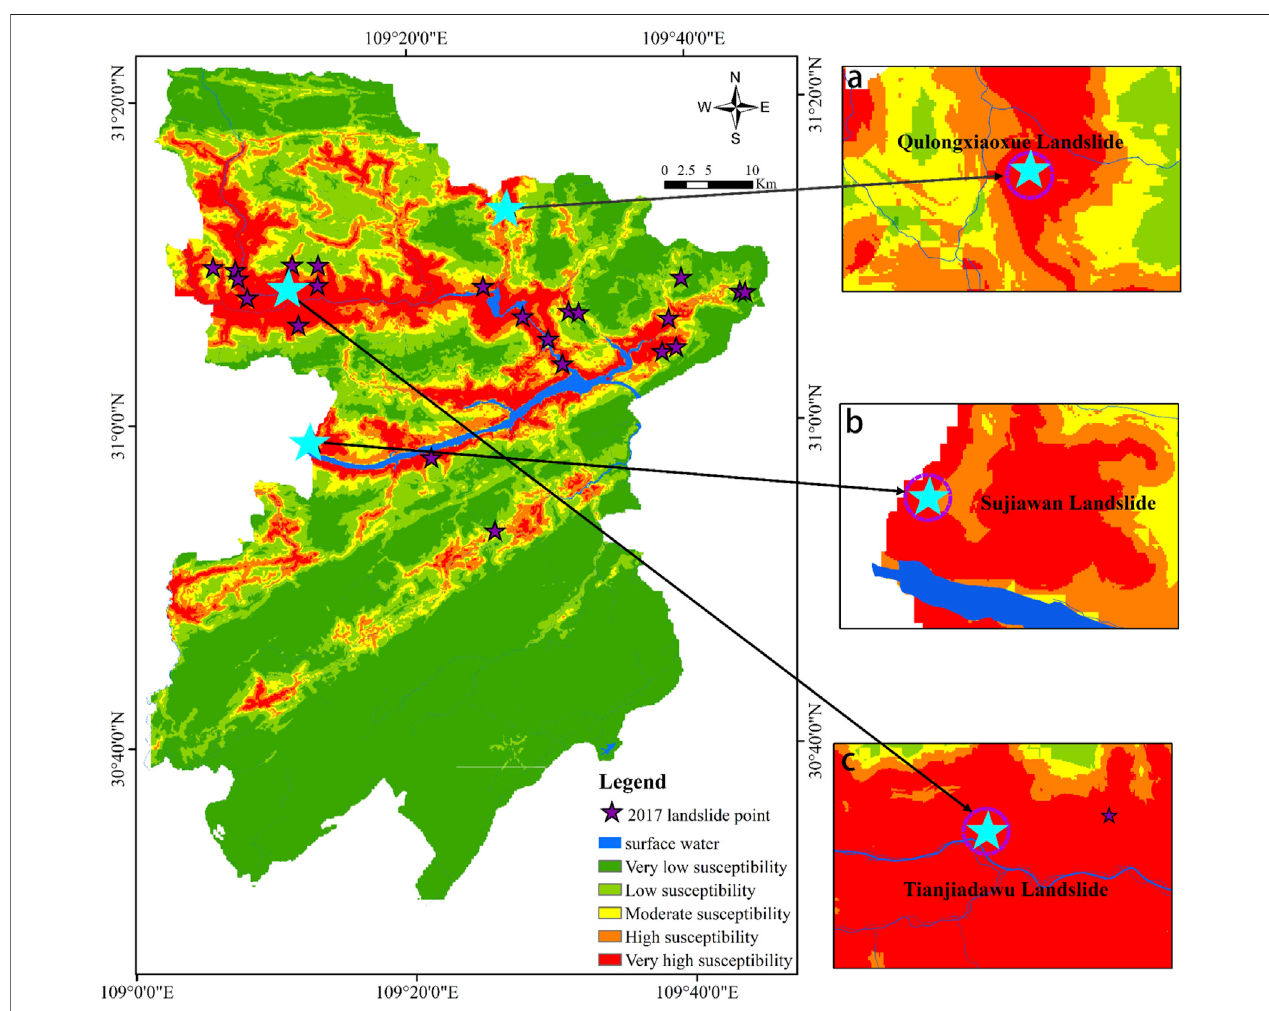
FIGURE 7 | Landslide susceptibility mapping based on the LR bo model vs. the geospatial distribution of new landslides.